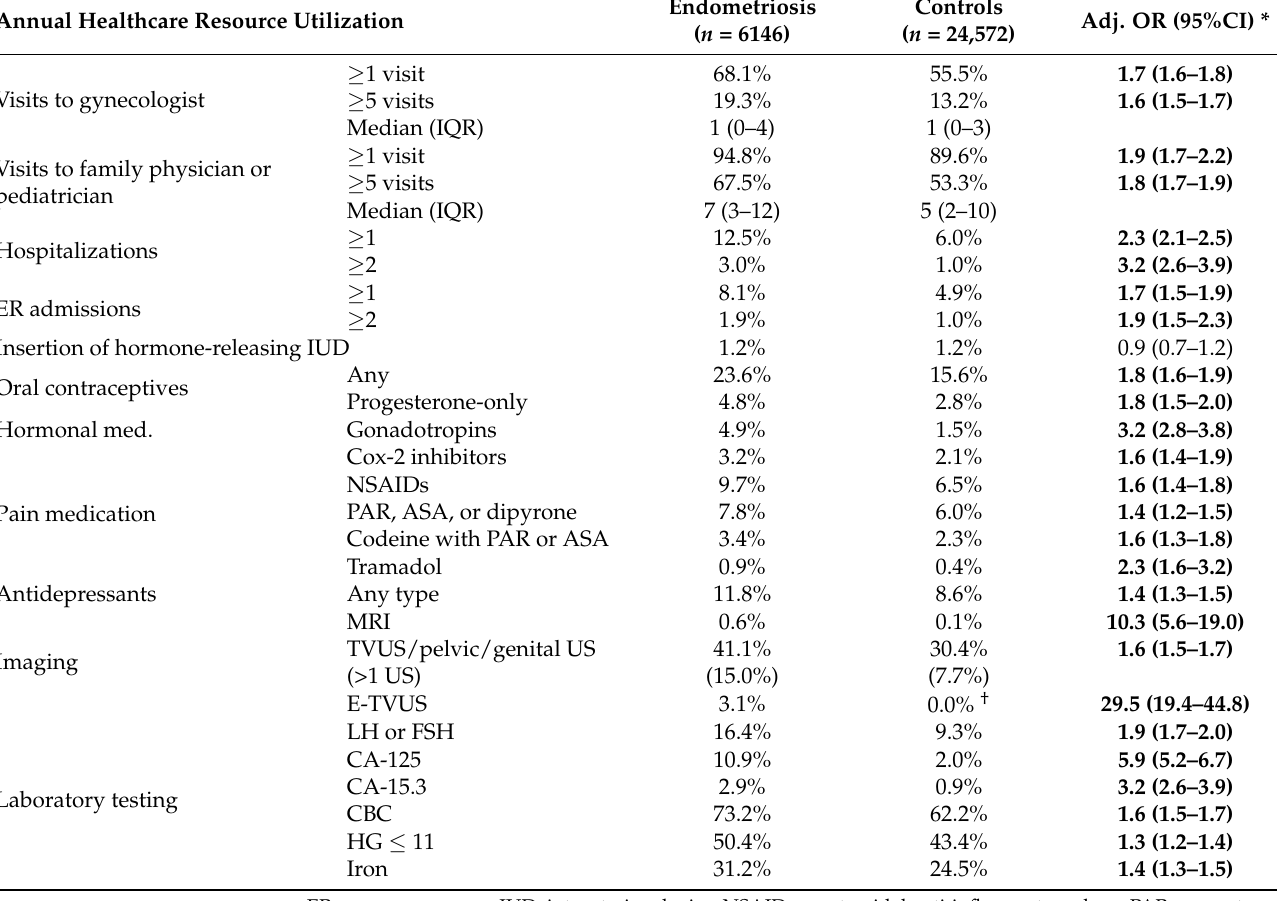
Table 3. Annual healthcare resource utilization of women diagnosed with endometriosis compared to matched controls.